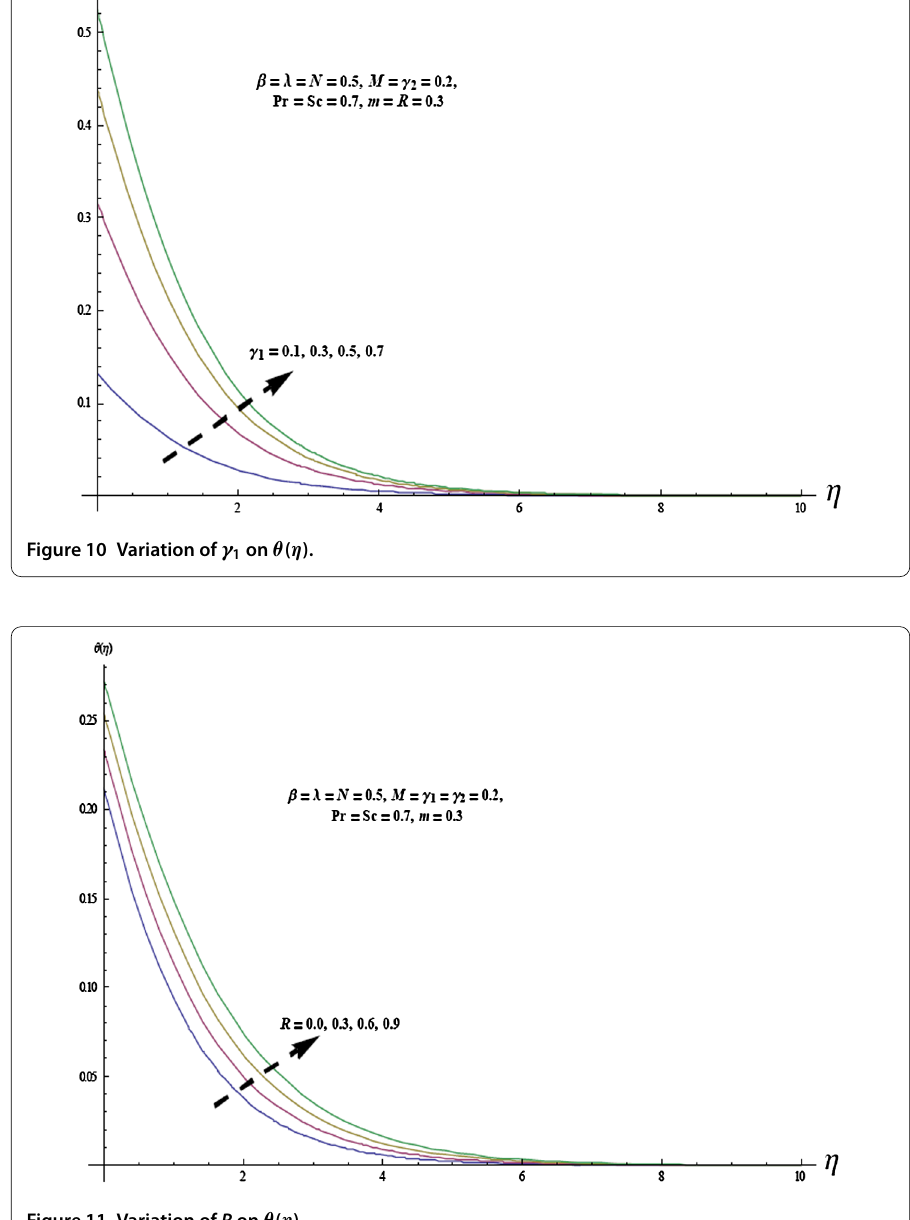
Figure 11 Variation of R on θ ( η